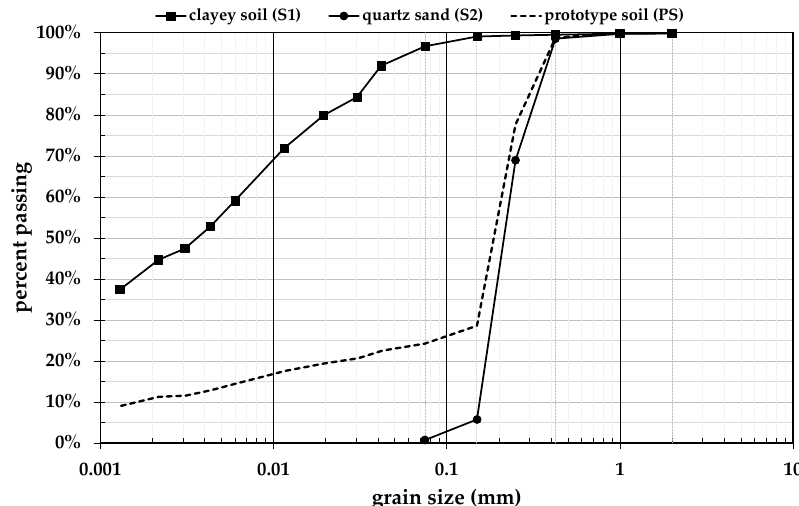
Figure 3. Grain size distribution of the materials under study: S1 (clayey soil); S2 (quartz sand); PS (prototype soil).